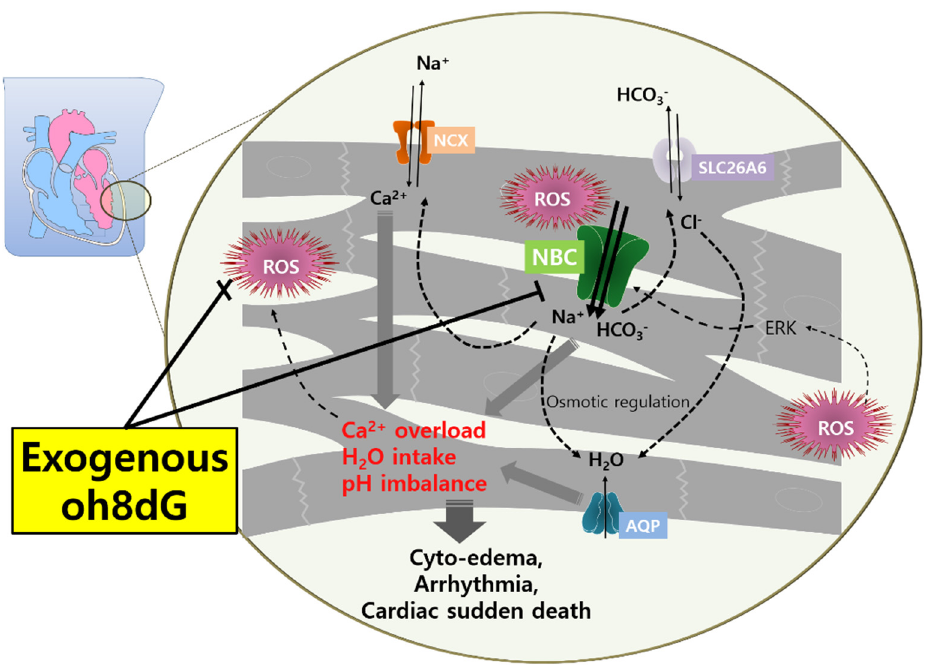
Figure 6. Schematic model of enhanced NBC and its coordinated channels and transporters in HTK- exposed cardiomyocytes and preserving effect of exogenous oh8dG. HTK-solution-exposed cardiac tissues produce oxidative signals. Oxidants enhance cardiac NBC activity through the involvement of ERK [51] and, subsequently, induce convergent involvement of NCX, CBE (SLC26A6), and aquaporin (AQP), which cause calcium overload and cyto-edema during reperfusion [16]. Cardiac calcium overload also mediates ROS generation [52]. Thus, the modulation of NBC activity may be a potential strategy against cardiac damage such as arrhythmic events or cardiac sudden death. The application of exogenous oh8dG may attenuate HTK-mediated NBC hyperactivity and the associated damage markers.